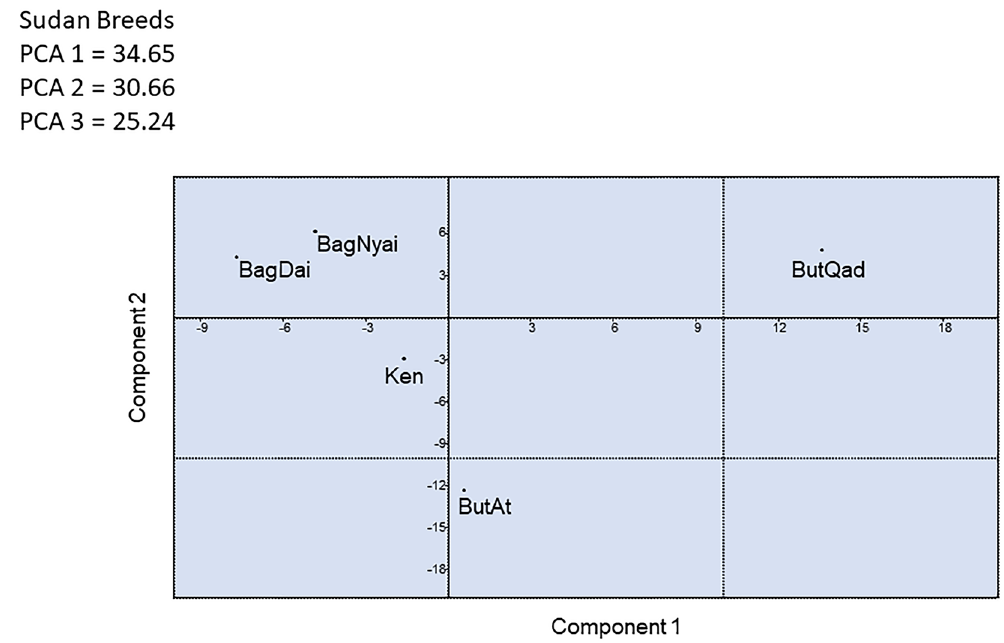
Figure 7. Principal components analysis of allele frequencies from the BoLA-DRB3 gene in five Sudan native samples sites (BagDai = Baggara Daiwani, BagNyai = Baggara Nyakawi, Ken = Kenana, ButAt = Butana Bu Atbara, and ButQad = Butana Bu